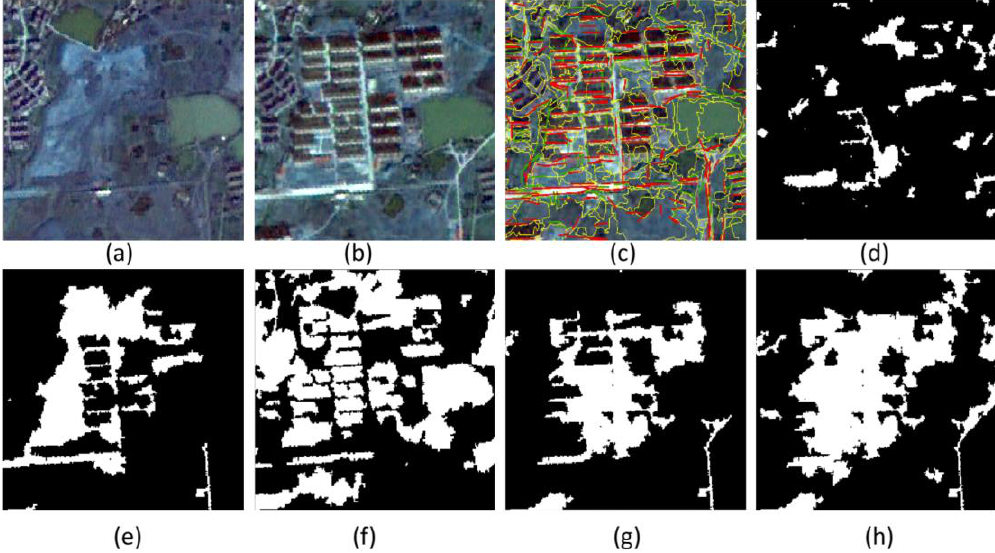
Figure 10. Enlarged area 3. ( a , b ) Original images. ( c ) TRPs and TLPs. ( d ) Result of CVA. ( e ) Result of PCA-k-means. ( f ) Result of IRMAD. ( g ) Result of initial detection. ( h ) Result after refinement.